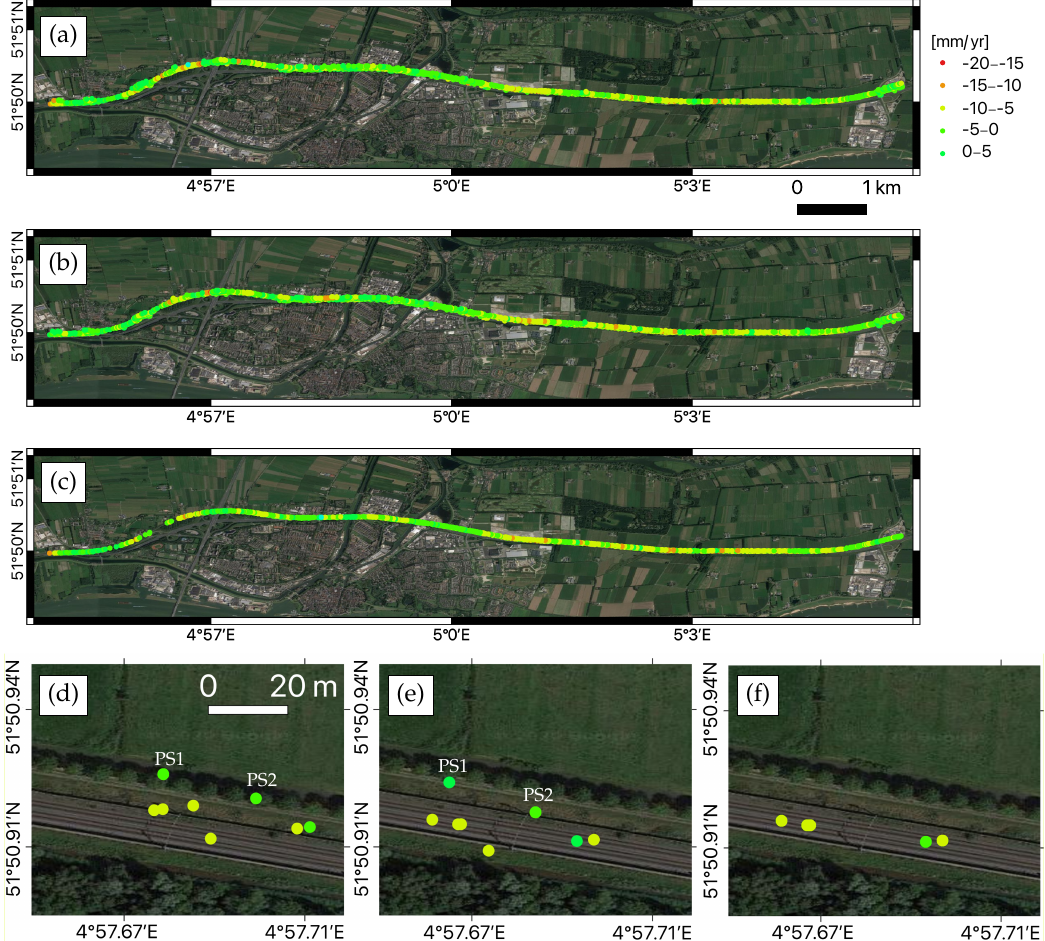
Figure 5. Line of Sight (LOS) deformation velocity map ( a ) before and ( b ) after 3-D geolocation improvement, and ( c ) of persistent scatterers (PS) on rails. Subfigures ( d – f ) separately illustrate the zoomed-in map before and after 3-D geolocation improvement, and of PS on rails, over an example